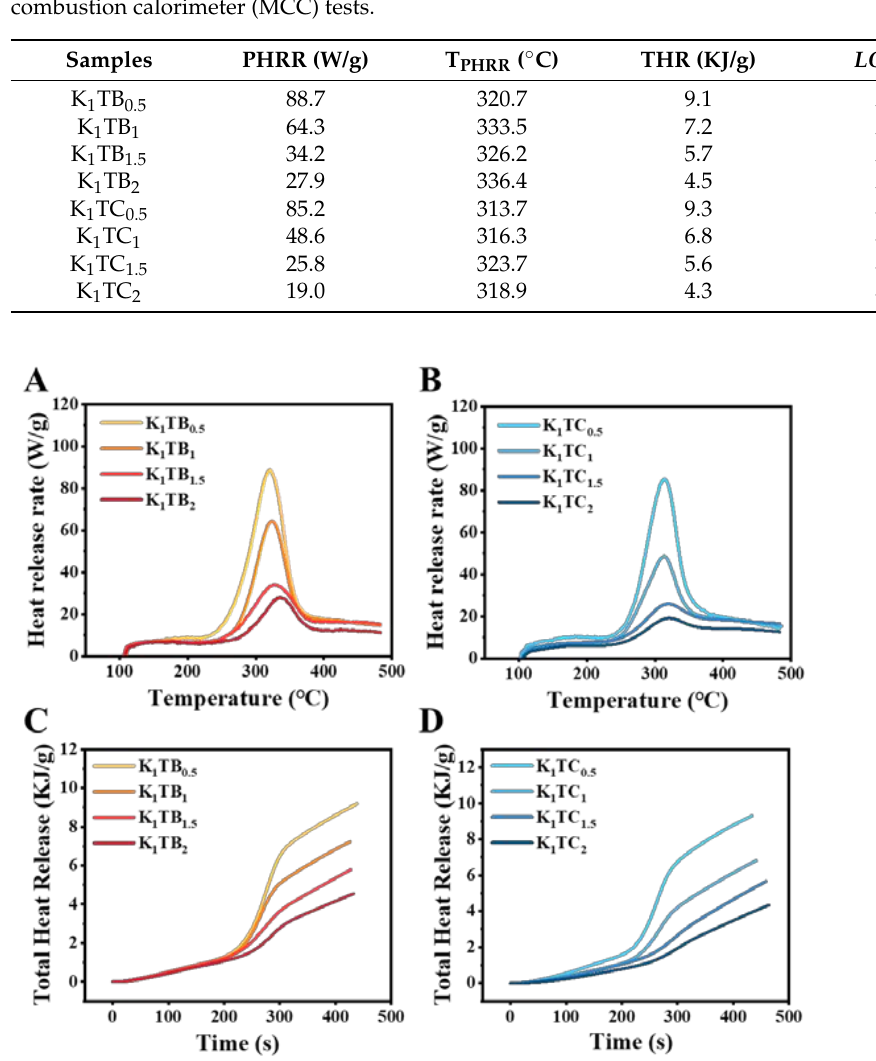
Figure 9. Heat release rate (HRR, A , B ) and total heat release (THR, C , D ) plots of KTB and KTC aerogels. Table 3. The flame retardancy of aerogel samples from limiting oxygen index ( LOI ) and microscale combustion calorimeter (MCC) tests.